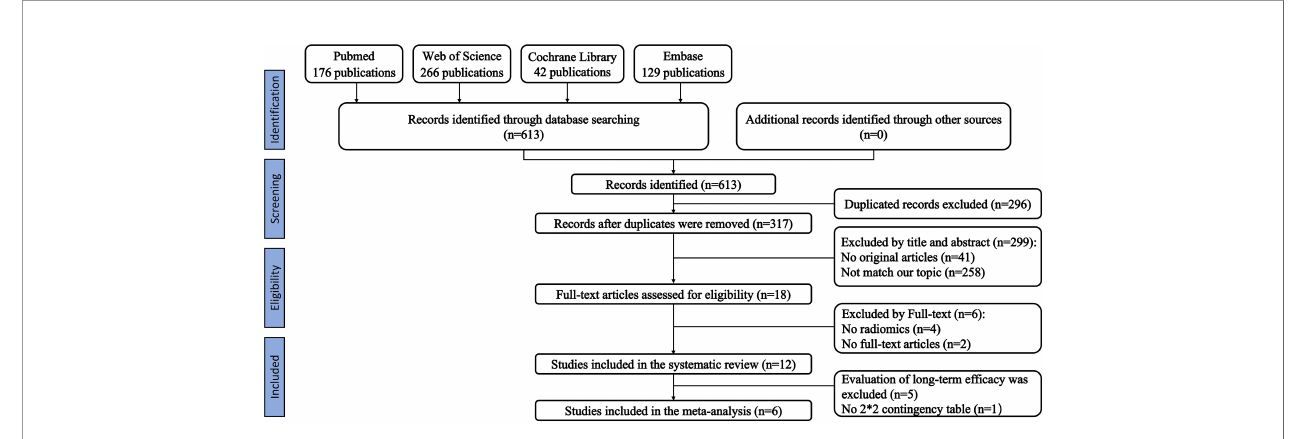
FIGURE 1 | A schematic of the publication selection